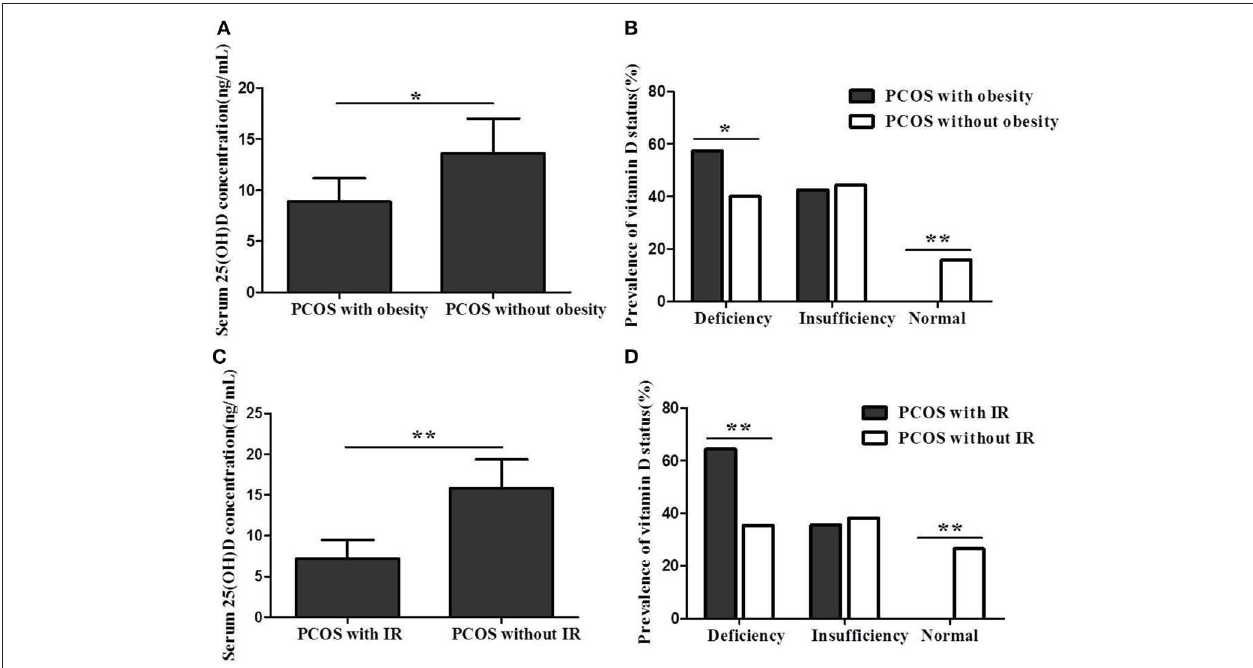
FIGURE 2 | (A) Serum 25(OH)D concentration between PCOS women with obesity and women without obesity. (B) Vitamin D status between PCOS women with obesity and women without obesity. (C) Serum 25(OH)D concentration between PCOS women with IR and women without IR. (D) Vitamin D status between PCOS women with IR and women without IR (* P < 0.05, ** P < 0.01).